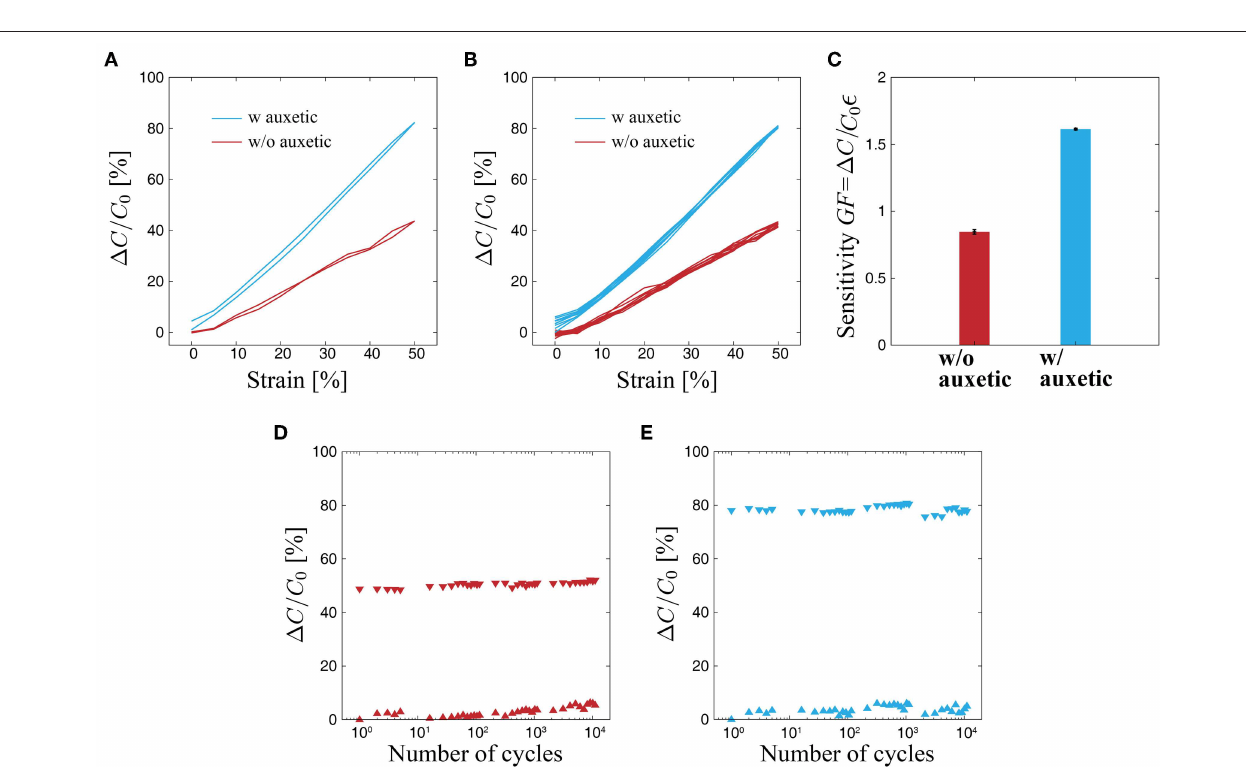
FIGURE 4 | Characterization results of the fabricated sensors. (A) Capacitive change as a function of the applied strain for one cycle. (B) Capacitive change as a function of the applied strain for five cycles. (C) Calculated sensitivity of the sensors. (D) Response of the sensor without the auxetic structure for 11,135 cycles. (E) Response of the sensor with the auxetic structure for 11,135